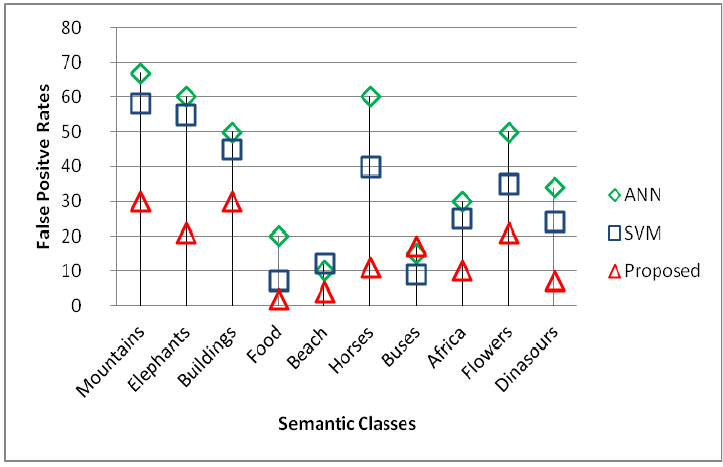
Figure 8. False positive comparison against ANN and SVM classifiers in terms of false positive